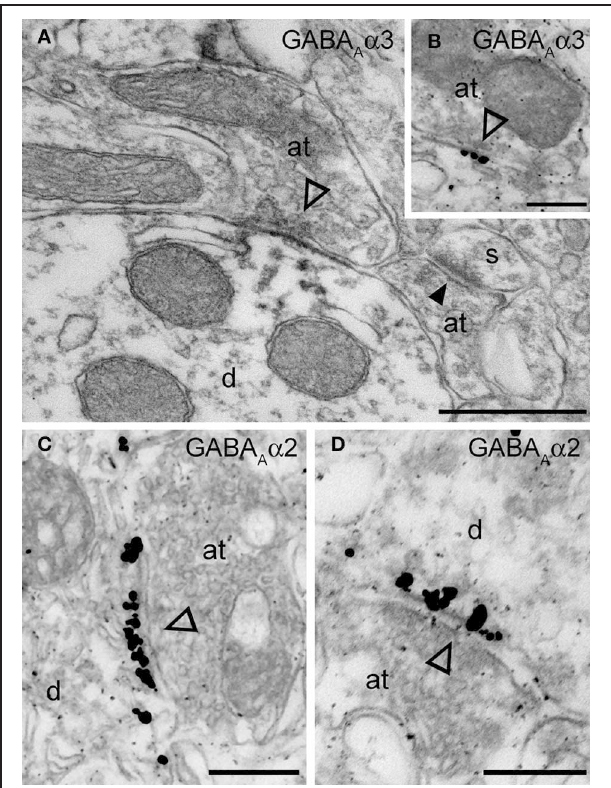
FIGURE 4 | Electron micrographs of the immunolocalization of the α 2 and α 3 subunits in Imp synapses. (A) A symmetric synapse (indicated by the open arrowhead) on an Imp dendrite shows electron dense peroxidase reaction end product for α 3 enriched at the plasma membrane of the postsynaptic specialization. Because the antibody recognizes an extracellular epitope, also the presynaptic active zone and some intracellular organelles located immediately underneath the postsynaptic membrane appear labeled due to the diffusion of the HRP-immunoreaction product. Nearby an immunonegative excitatory synapse (closed arrowhead) made with a small spine(s) can be observed. (B) Immunometal particles visualizing α 3 subunits can be seen directly located at the postsynaptic membrane of an inhibitory synapse in the Imp. ( C and D ) Numerous immunometal particles identifying the GABA A α 2 subunit can be observed leaning on the cytoplasmic portion of the postsynaptic plasma membrane of a symmetrical inhibitory synapse (open arrowheads) in the Imp. Abbreviations: at, axon terminal; d, dendrite; s, spine. Scale bars: A, 500nm; B, 200nm; C, 250nm; D,